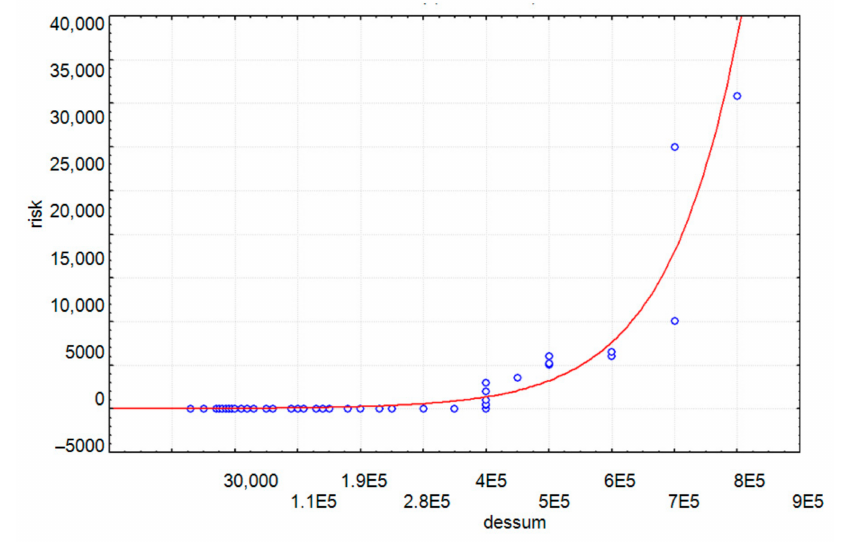
Figure 4. Graph of the dependence of the risk on loan value